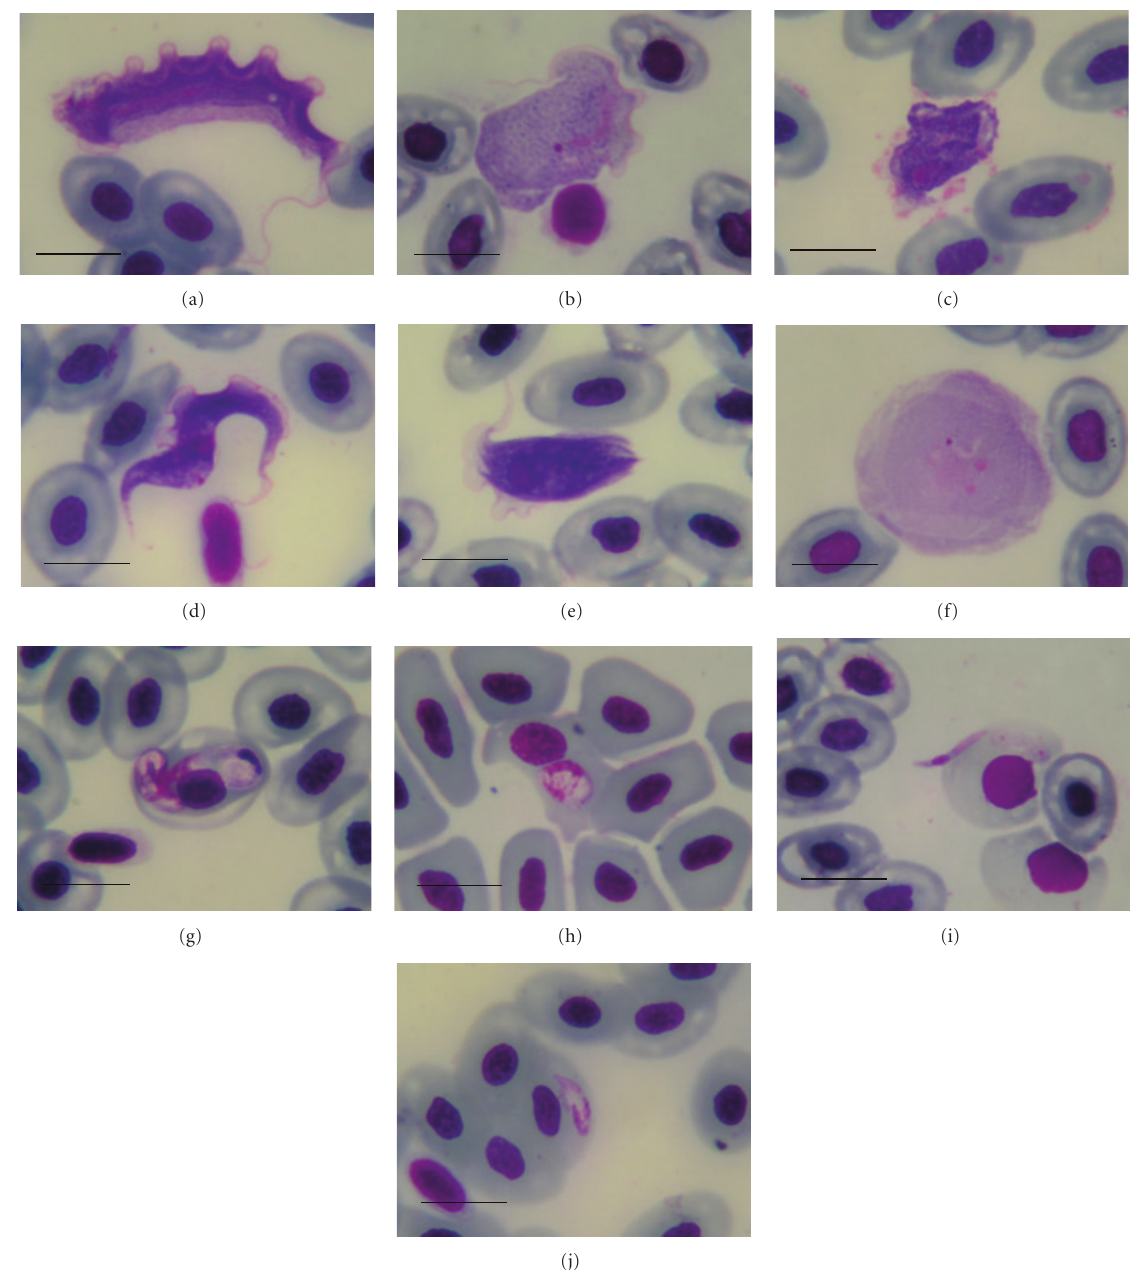
Figure 1: Photomicrographs of the blood parasites of Hoplobatrachus rugulosus , Trypanosoma rotatorium -like I form (a), Trypanosoma rotatorium -like II form (b), Trypanosoma rotatorium -like III form (c), Trypanosoma rotatorium -like IV form (d), Trypanosoma rotatorium - like V form (e), Trypanosoma chattoni (f), mature gamont of Hepatozoon sp. a in red blood cell associated with large parasitophorous vacuole (g), mature gamont of Hepatozoon sp. b in red blood cell (h), extracellular sporozoite of Lankesterella minima (i), merozoite of Lankesterella minima in red blood cell (j) Giemsa’s stain, (Bar = 10 µ